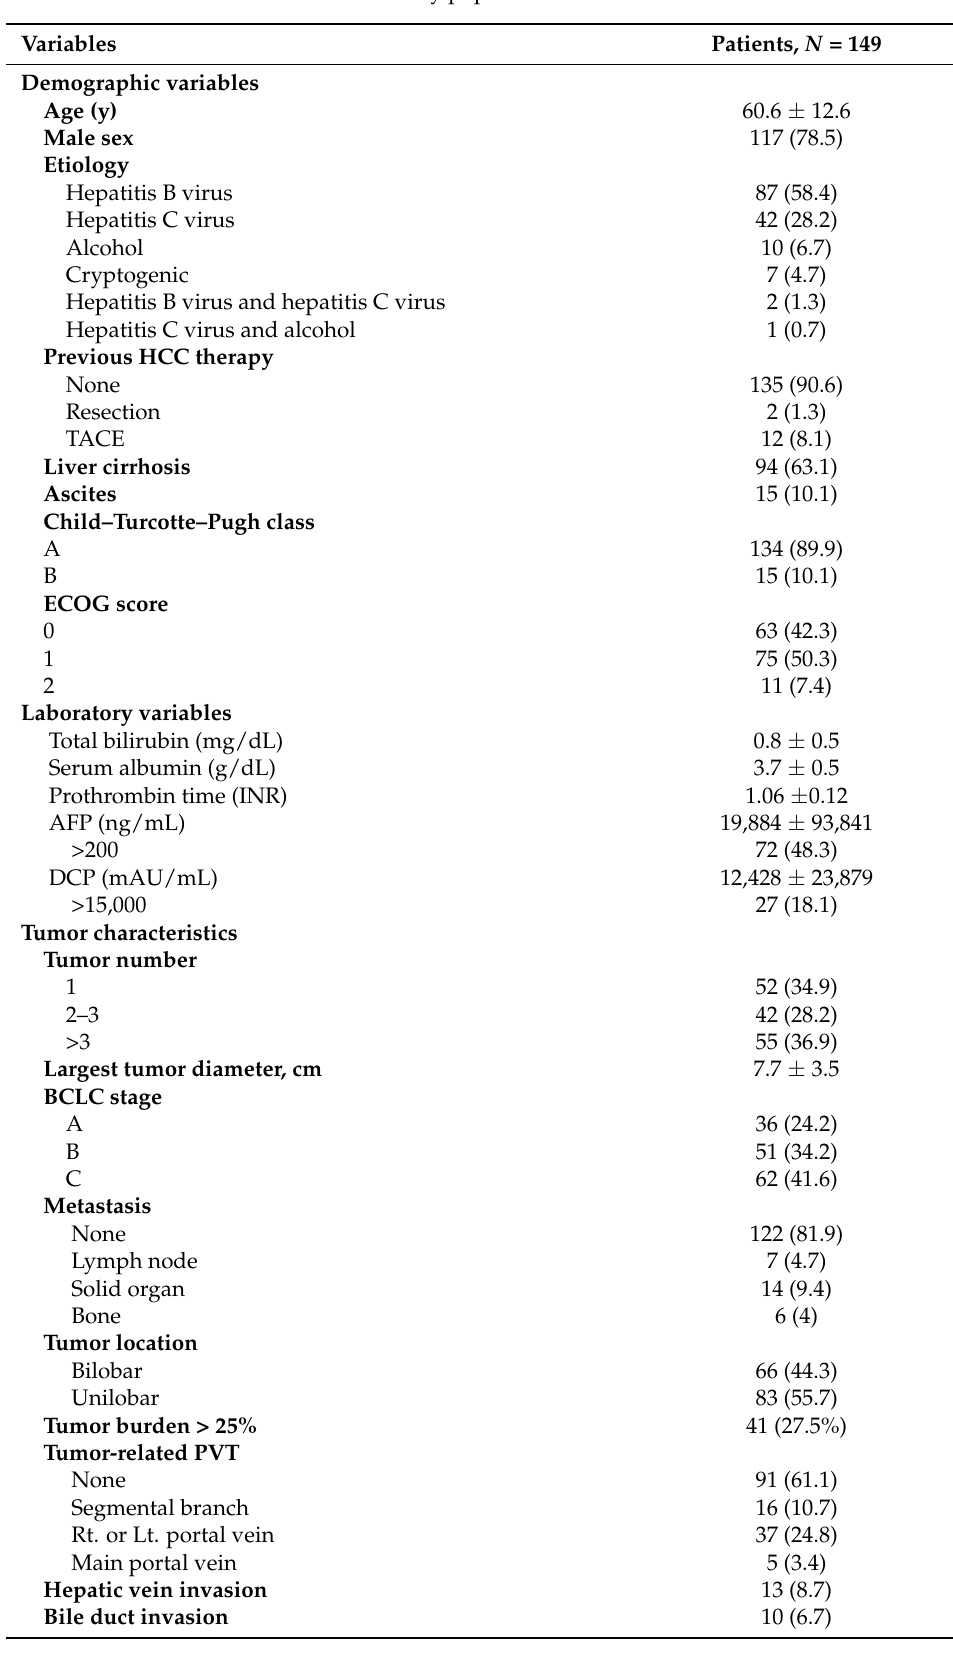
Table 1. Baseline characteristics of the study